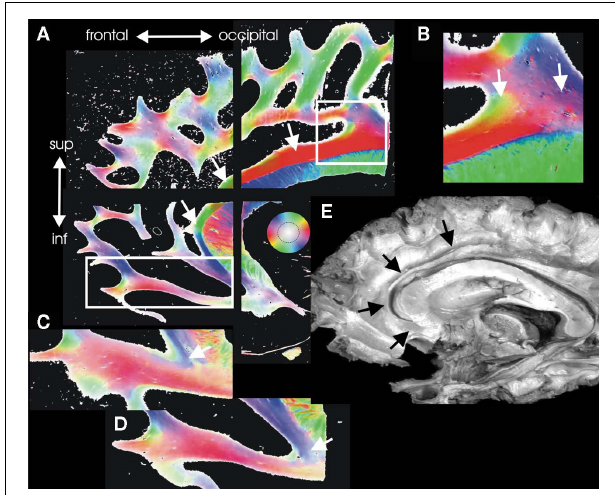
FIGURE 3 |Architectural parcellation of the anterior cingulum bundle. The cingulum bundle is marked by the white arrows in the Fiber Orientation Maps [FOMs (A)] . (E) Shows the cingulum bundle in a dissected human brain for comparison (black arrows).The anterior supracallosal and the pregenual part of the cingulum bundle is a single compact fiber bundle [white arrows in (A) ]. In its midcingulate posterior part, the supracallosal cingulum bundle gets several inputs from fiber bundles coming from the adjacent white matter.This part is magnified in (B) and shows intermingling fiber bundles running into the cingulum bundle visualized in green and blue color (arrows). In the subgenual part, the fibers of the cingulum bundle curve and spread into the orbitofrontal regions [ (C,D)